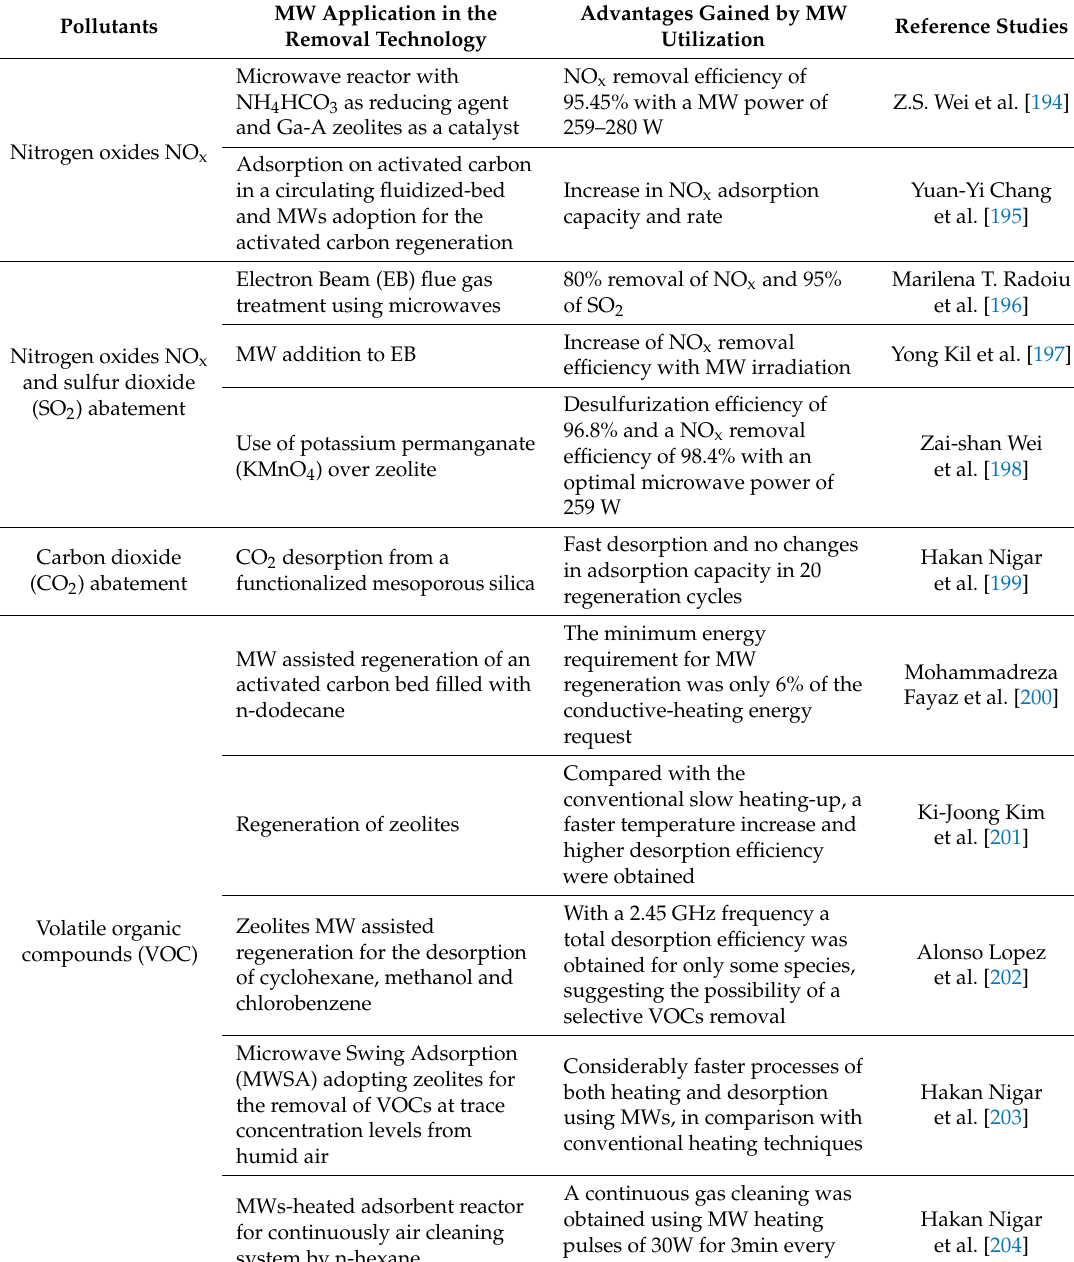
Table 2. Microwave (MW) application and obtained advantages of their use in the abatement of air and water